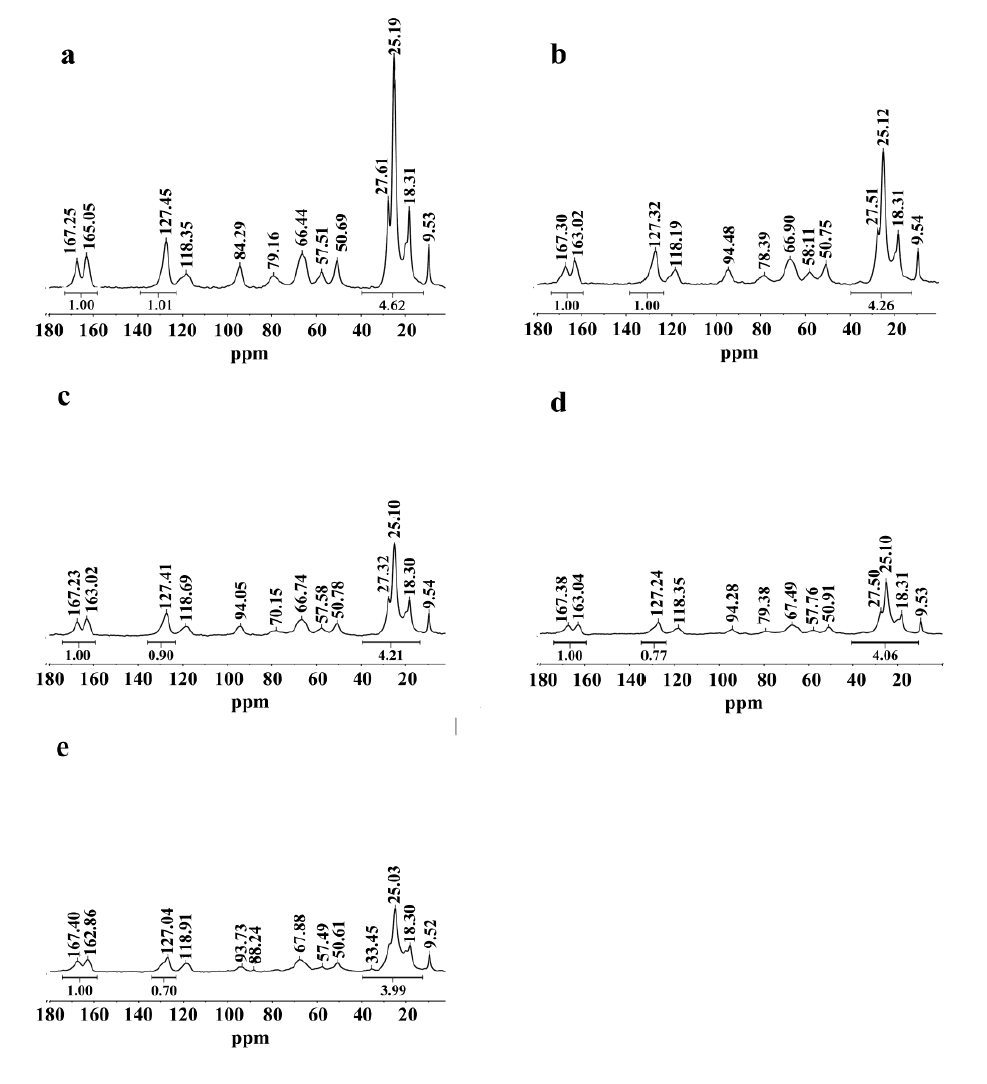
Figure 2. 13 C-NMR spectra of N -phthaloyl acylated chitosan with different crosslinking densities ( a ) 7.4%, ( b ) 5.9%, ( c ) 4.4%, ( d ) 2.9%, and ( e )